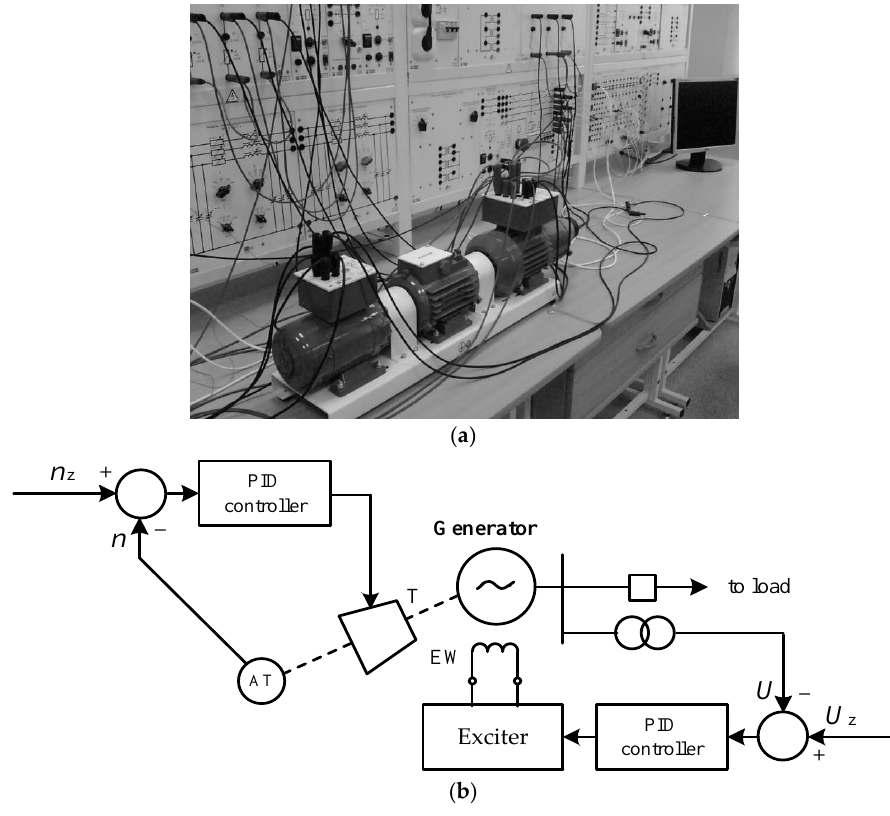
Figure 15. Photo ( a ) and functional diagram ( b ) of the DG plant physical model.